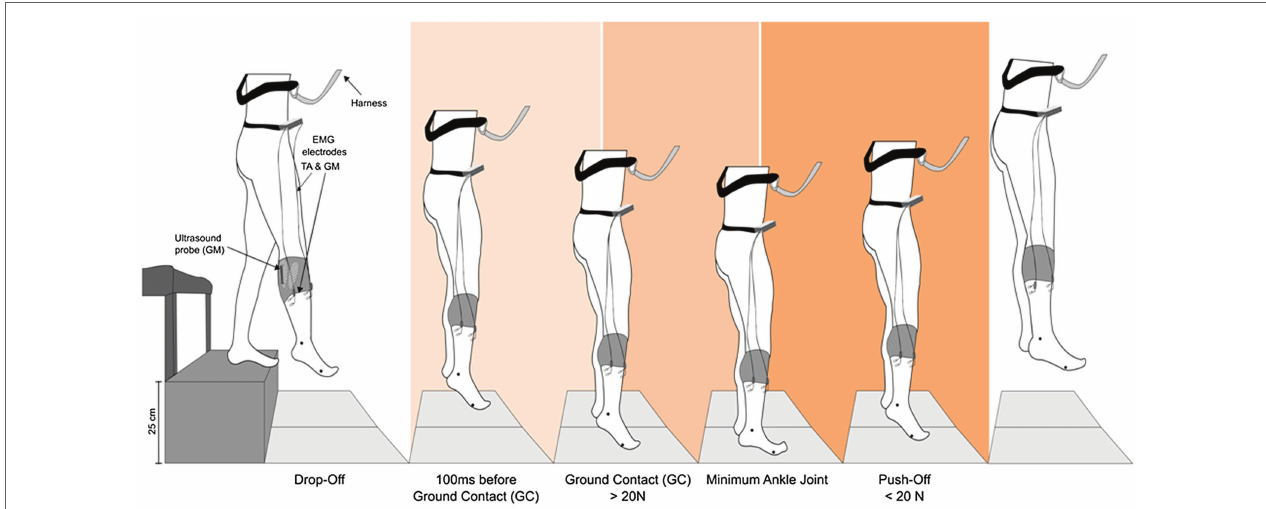
FIGURE 2 | Schematic overview of the experimental setup. Subjects performed drop jumps from a rack with a drop height of 25 cm to separated AMTI force plates. Additionally, they were safely attached to a harness during the whole flight. Electromyographic activity (EMG) of the gastrocnemius medialis (GM) and tibialis anterior (TA) muscles was recorded using Ag/CL electrodes. For monitoring the GM fascicle behavior, a linear ultrasound probe was placed on the muscle belly and secured with a unique device in order to avoid probe’s movements against the skin. 2D kinematic markers were placed on the malleolus and the fifth metatarsal